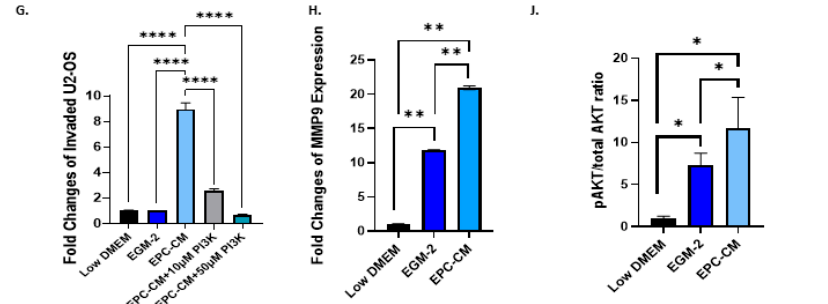
Figure 1. EPCs promote OS migration and invasion via PI3K/AKT signaling. ( A ) Representative H&E staining and CD31 immunolabeling of human OS lung metastasis (N = 18) and non-metastatic (N = 7) specimens. Cytoplasmic and membranous labeling patterns were obtained. Images were obtained under ×40 microscope magnification. Scale bar denotes 50 µm. ( B ) Quantitative analysis of blood vessel density (1/µm 2 ) in metastatic vs. non-metastatic OS specimens. Vessel density was 30-fold higher in metastatic samples when compared to primary tumors; **** p < 0.0001. ( C ) Representative time-lapse microscopy images of U2-OS under different culture conditions: Low DMEM, EGM-2, EPC-CM, EPC-CM + 10 µ M PI3Ki, and EPC-CM + 50 µ M PI3Ki at 0 and 16 h. Images were obtained under × 10 magnification. Scale bar denotes 100 µ m. ( D ) U2-OS migration rate. ( E ) Statistical analysis of U2-OS wound confluence under different culture conditions at 10 h. Wound confluence of cells cultured with EPC-CM was significantly higher compared to both controls (Low DMEM/MEM-Eagle and EGM-2); **** p < 0.0001. Addition of PI3Ki to EPC-CM signifi- cantly attenuated OS cell migration in a dose-dependent manner compared to EPC-CM alone; ** p < 0.01, and **** p < 0.0001. ( F ) Representative microscope images of invading U2-OS cells in Low DMEM/EGM-2/EPC-CM/EPC-CM + 10 µ M PI3Ki and EPC-CM + 50 µ M PI3Ki. ( G ) Quantitative group compared to EGM-2 and Low DMEM. PI3Ki significantly attenuated U2-OS cell invasion in a dose-dependent manner compared to EPC-CM; **** p < 0.0001. ( H ) Real-time PCR analysis.